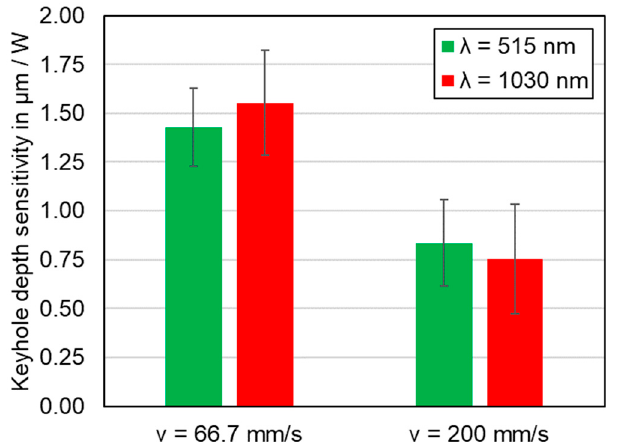
Figure 6. Keyhole depth sensitivity evaluated from linear welds for feed rates v = 66.7 mm/s and v = 200 mm/s for linearly increased laser power (P = 500 W–1500 W for λ = 515 nm laser radiation; P = 2000 W–3000 W for λ = 1030 nm).